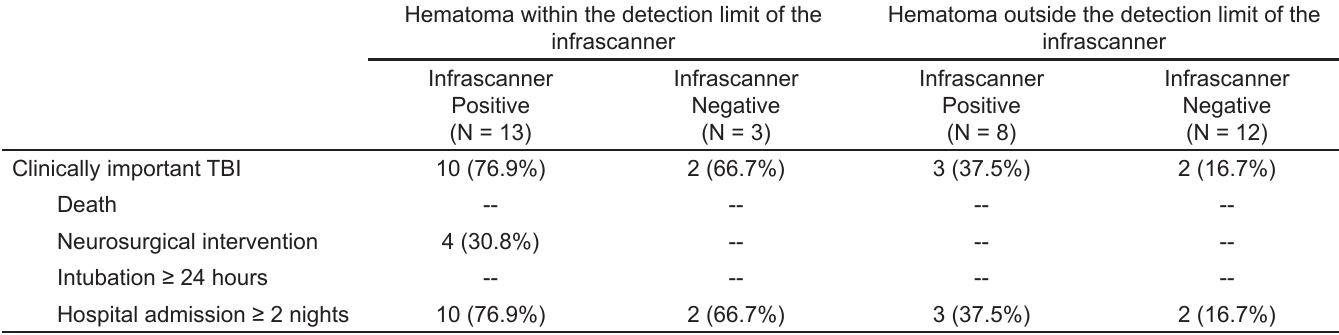
Table 3. Clinically important traumatic brain injury outcomes and detection limit of the handheld